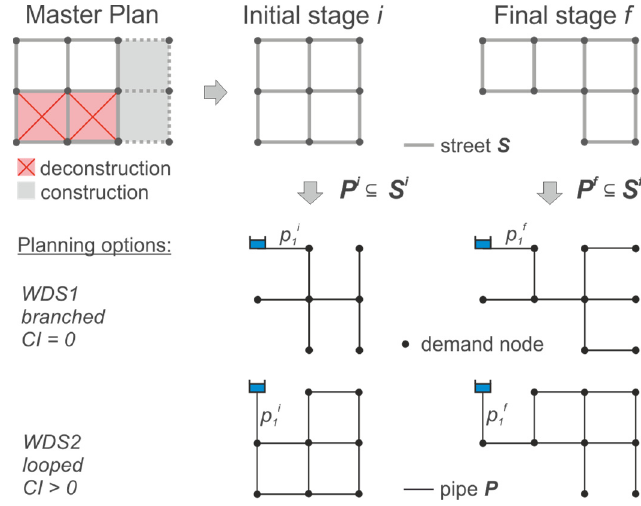
Figure 3. Long-term network dynamics in the concept of network generation by integrating stages in the design of the WDS.